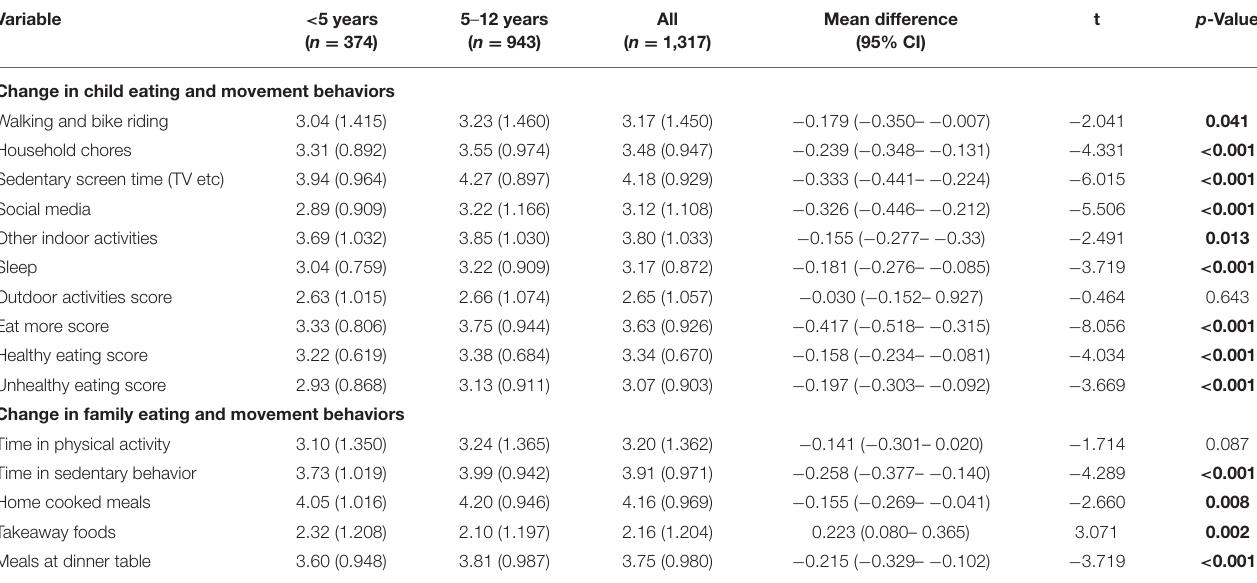
TABLE 3 | Changes in child and family eating and movement behaviors stratified by age group.